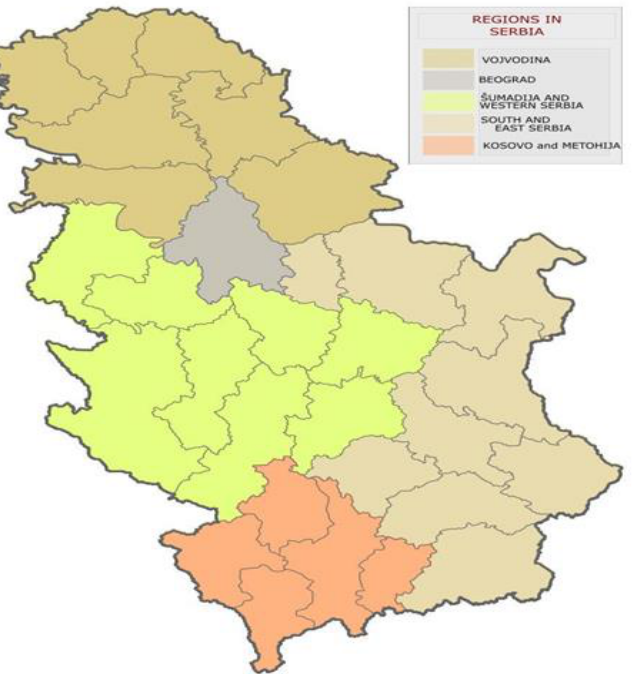
Figure 3. Research area in rural Serbia .